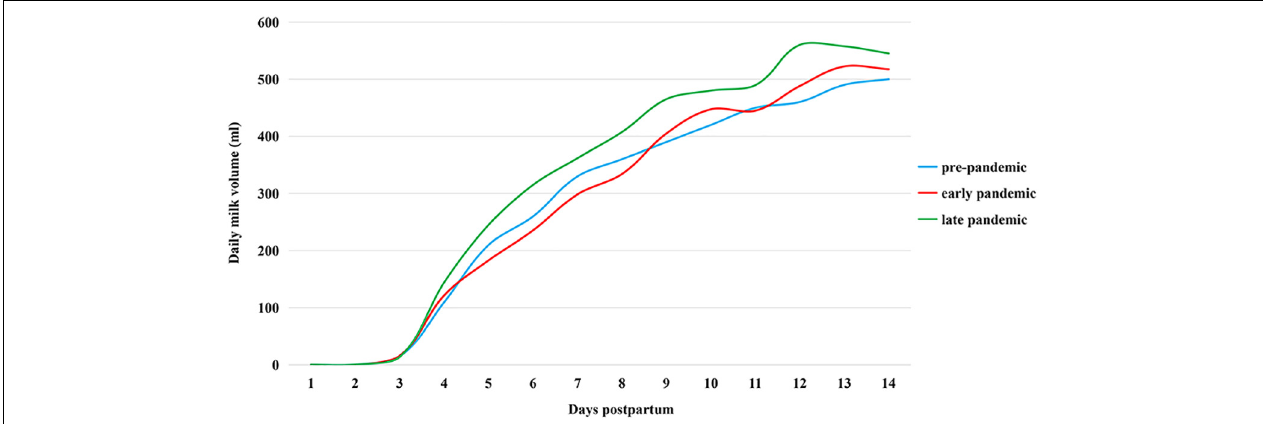
FIGURE 2 | Maternal milk volume in the two weeks postpartum in 2019–2020.